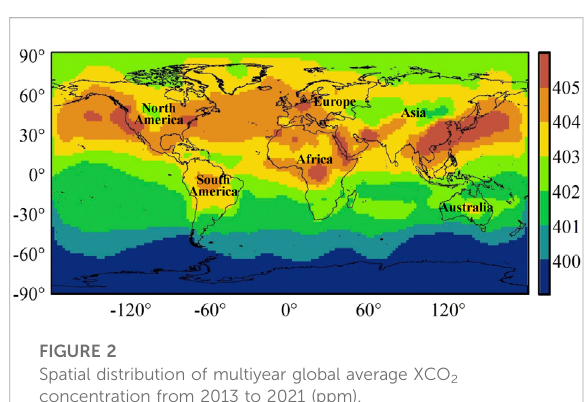
Spatial distribution of multiyear global average XCO 2 concentration from 2013 to 2021